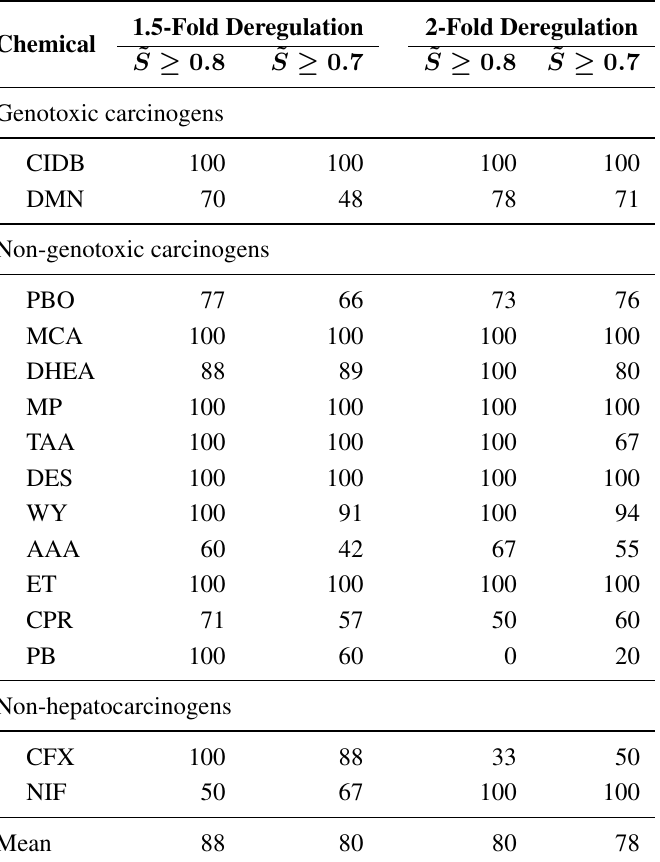
Table 3. Percentage of correctly identified conditions. The most similar conditions were extracted for each chemical in the evaluation set. The percentage of conditions with the same carcinogenicity class and a relative similarity above 0 . 8 and 0 . 7 was